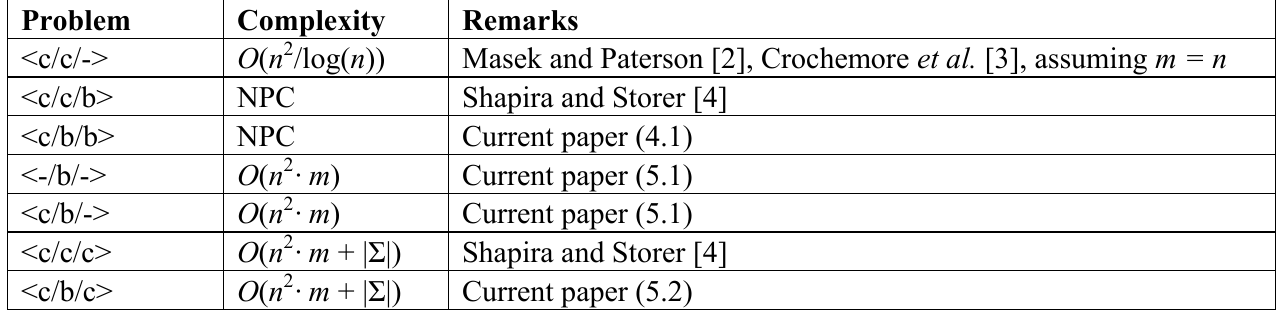
Table 1. Summary of